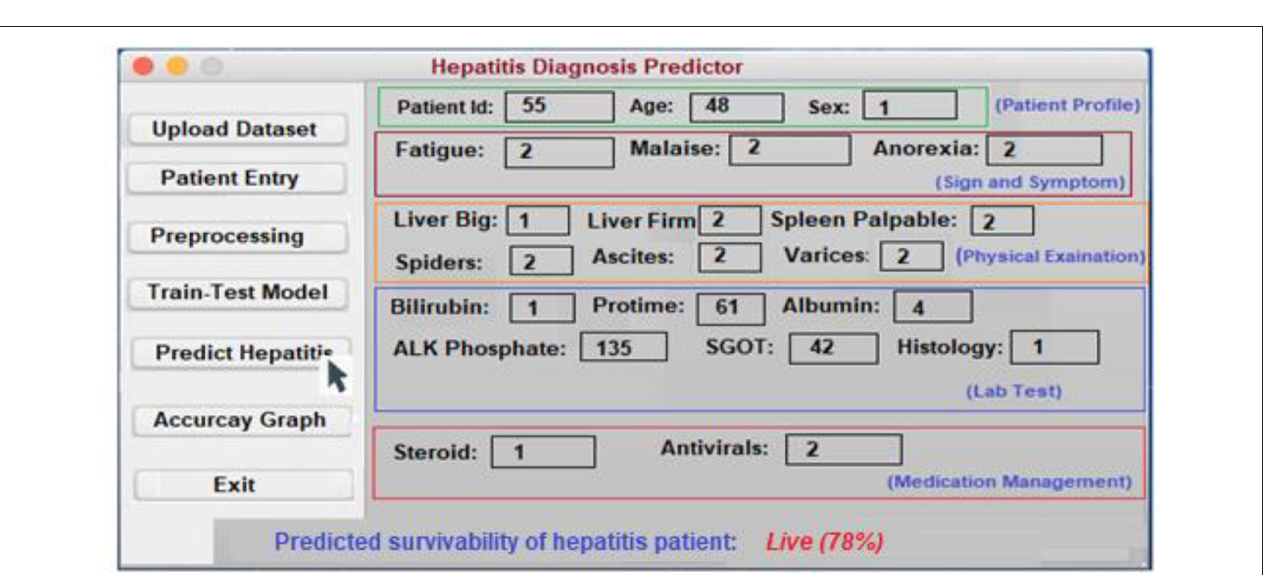
FIGURE 12 | The interface for predicting hepatitis. It serves as a training aid by displaying the loaded data. Model training is activated by clicking on the “train-test model” ( Figure 11 ). • Predicting survivability of Hepatitis Patient: To predict hepatitis, all you need to do is enter the necessary patient information and click the “Predict hepatitis” option on the site. The “Update Training Set” button activates an updated training set. After inputting the patient’s disease details and clicking on the “predict hepatitis” button, the findings are shown as “Hepatitis_patient_ survivability = yes,” “D2: Hepatitis_patient_ survivability = no,” and a predicted